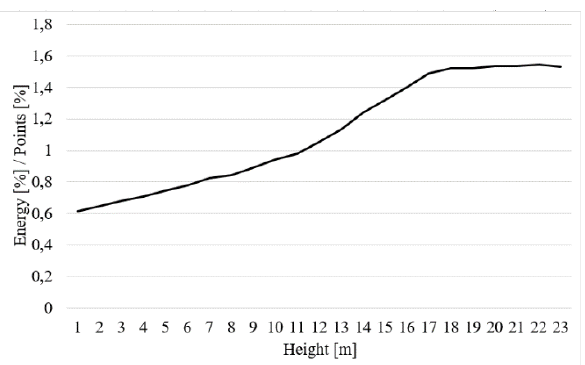
Figure 11. Ratio of percentage energy receipt to the percentage distribution of observer points of different height levels for the data of Figure